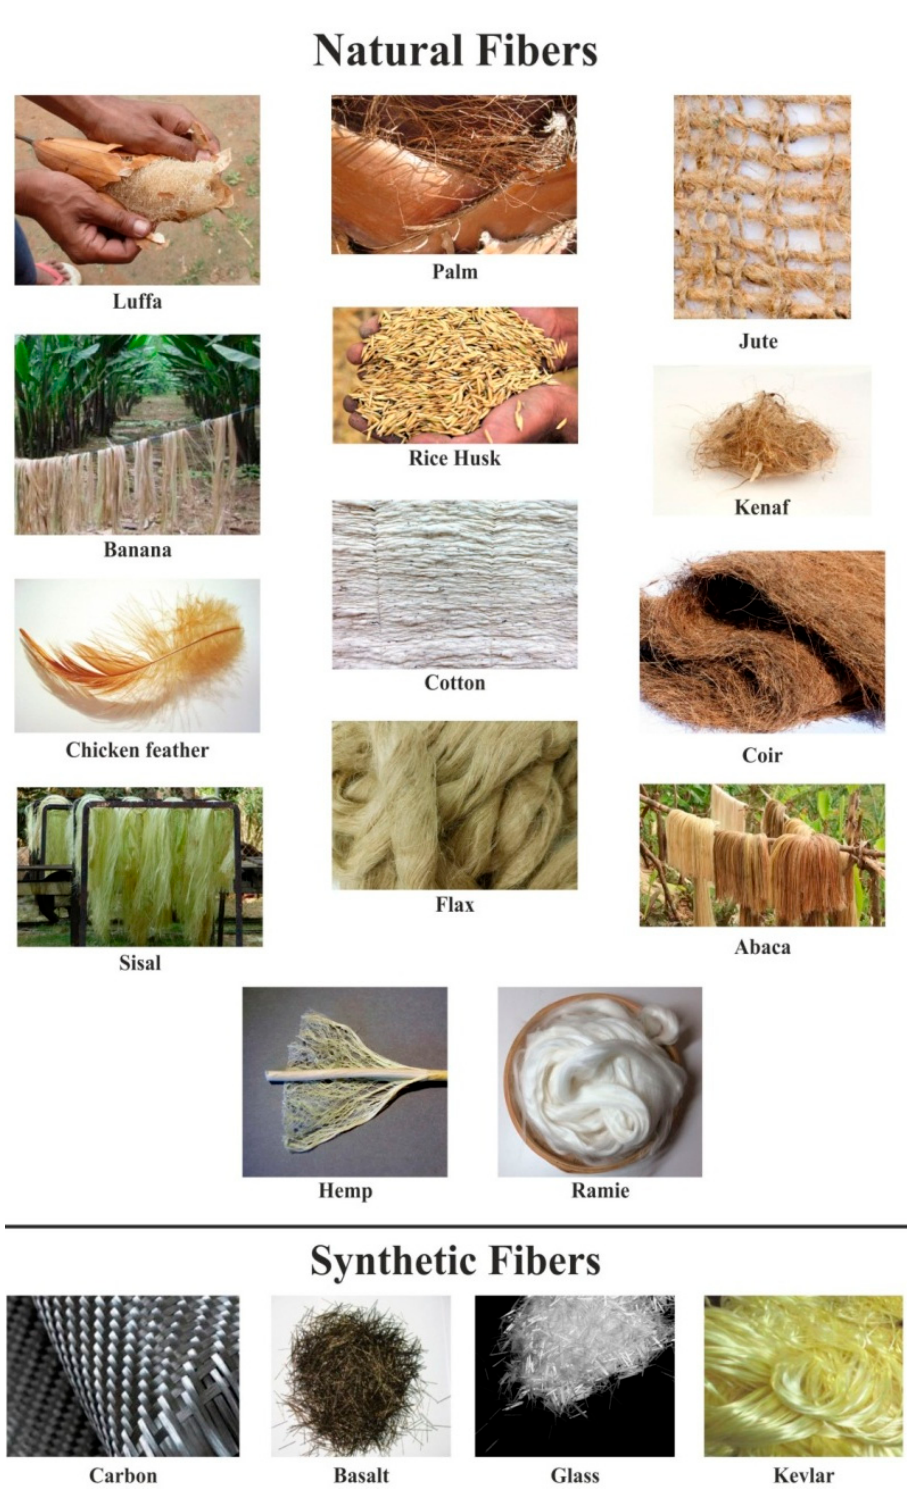
Figure 2. Classification of fibers, reproduced from [37–53] under open access license.